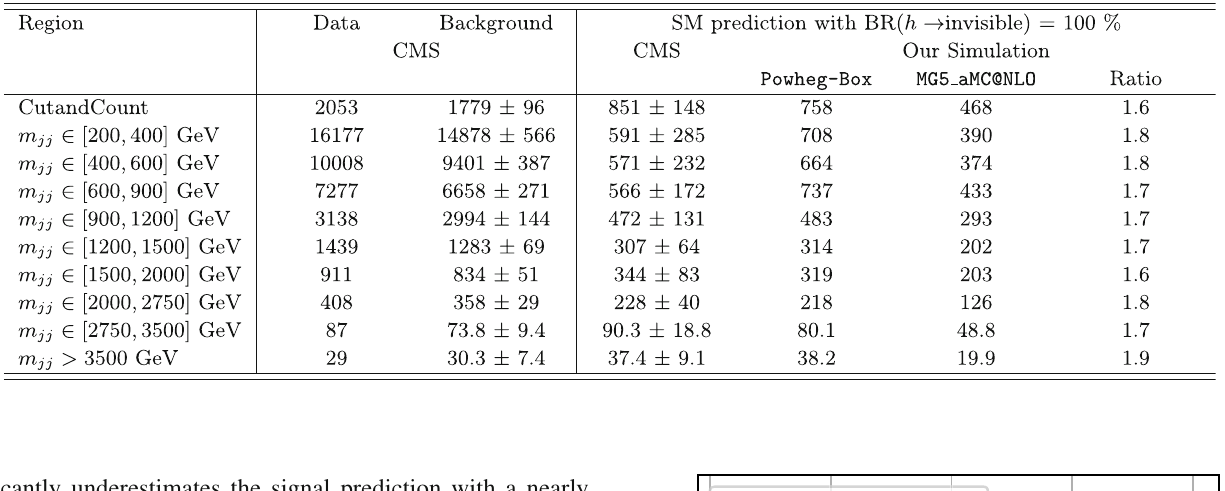
Table 2 Observed and expected number of events for all regions listed in Table 1. SM predictions are determined for an entirely invisibly decaying Standard Model Higgs boson with m h = 125 GeV produced both in Vector Boson Fusion and Gluon Fusion. CMS numbers are taken from Ref. [41] and compared to our numbers determined with